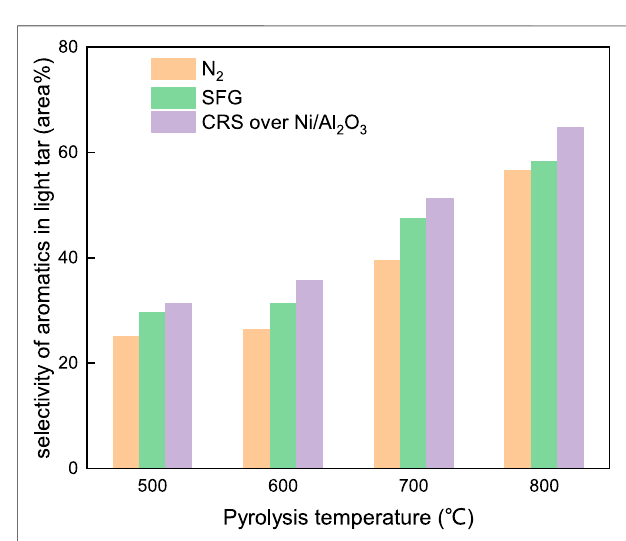
FIGURE 9 | The selectivity of the components in the light tar.